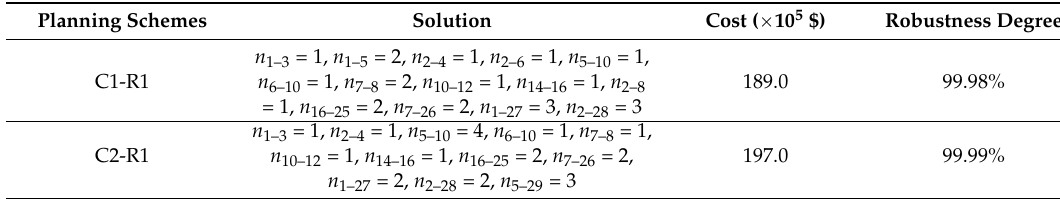
Table 5. Robustness analysis for C1 and C2.